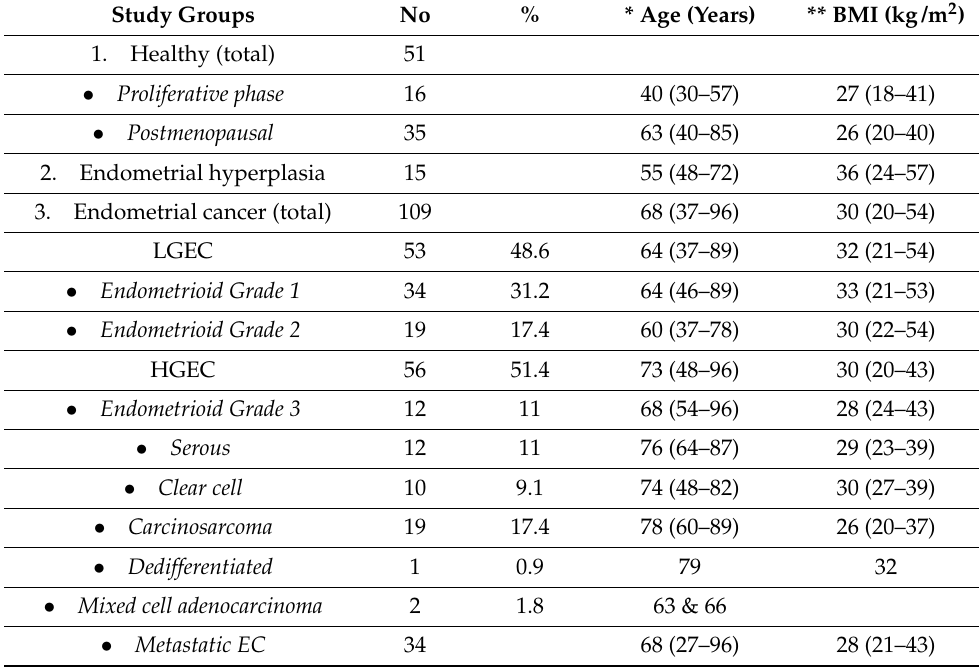
Table 1. Demographic features of study